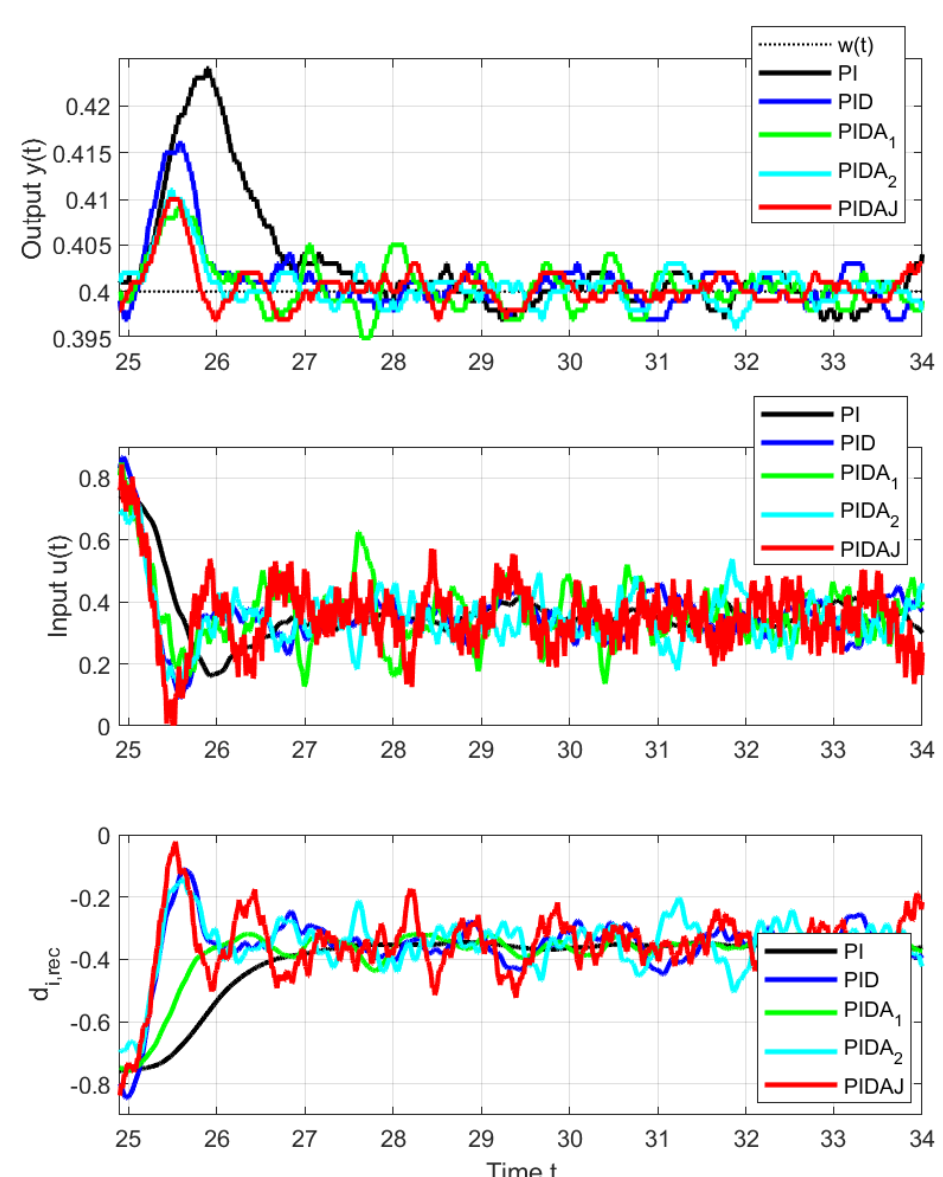
Figure 8. Details of load disturbance step responses from ∆ u = 0.5 to ∆ u = 0 at t = 25